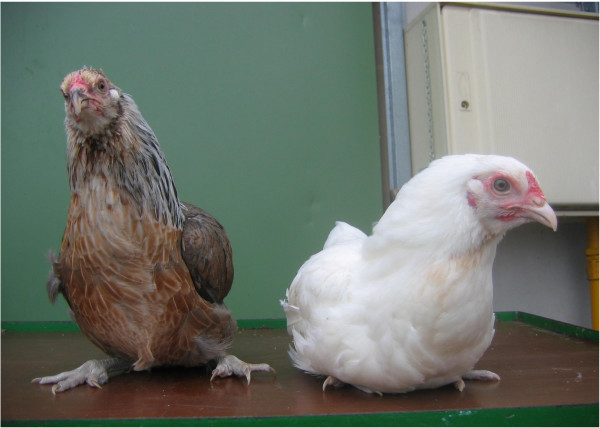
Comparison of plumage color in full sib chickens differing for their genotype at the C locus. On the left, a chicken carrying the wild type allele at the C locus exhibits a colored plumage as determined by other feather color loci. Here the animal carries the wild type allele at the Extension locus, the wild type allele at the Columbian locus and the silver allele at the Silver locus. On the right, a recessive white chicken, full sib from the previous one, exhibits full white plumage.